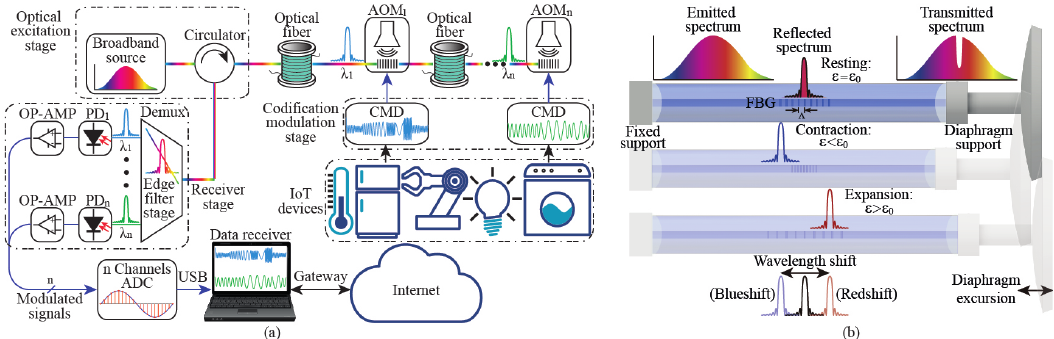
Figure 2. ( a ) Schematic of the proposed IoToF approach used to interlink several IoT devices to a receiver and ( b ) scheme of the fiber Bragg grating (FBG) operation principle.